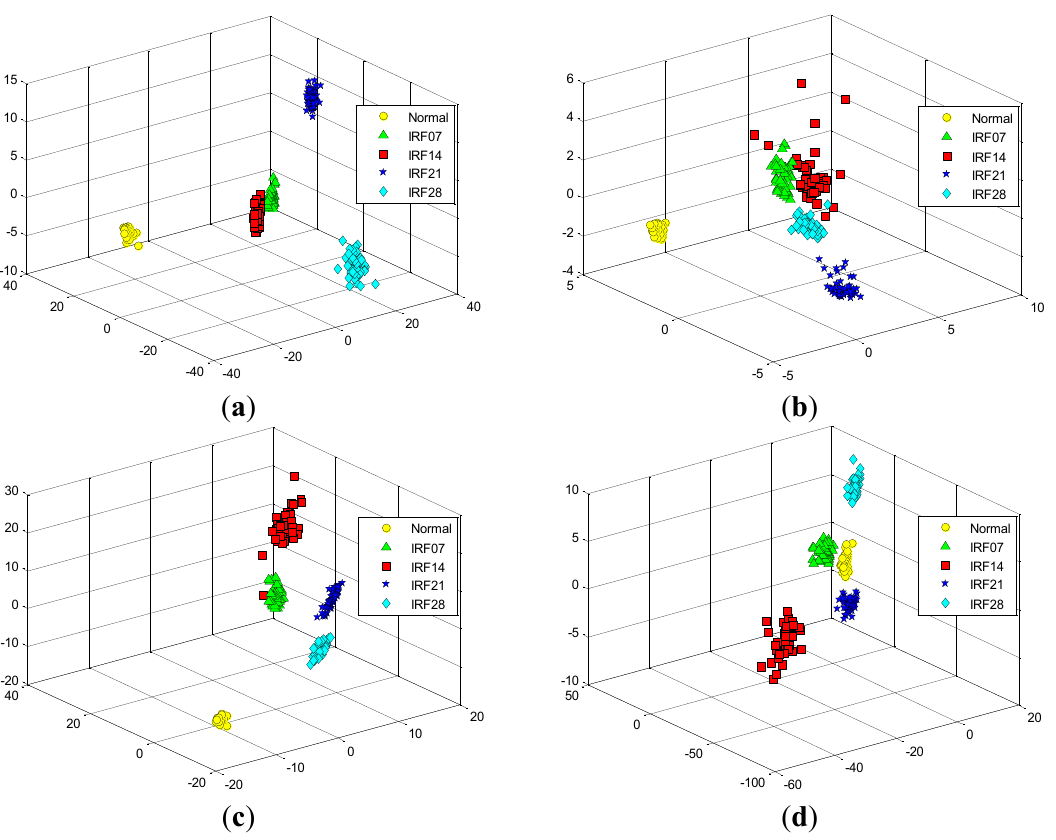
Figure 16. The data projection result with the first three eigenvectors in the D_IRF